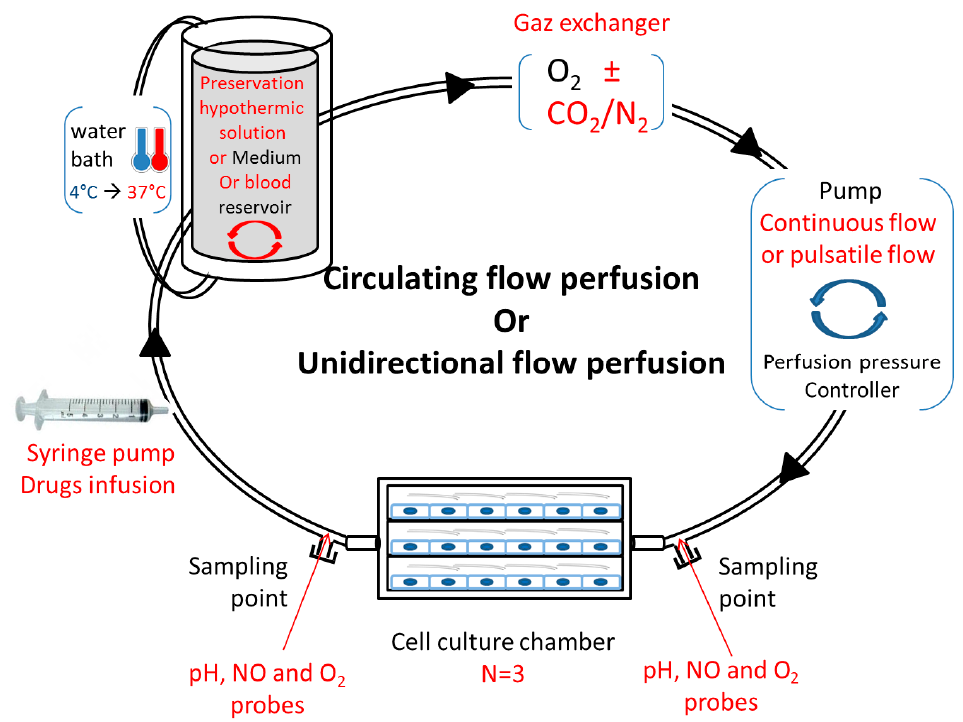
Figure 2. Proposition for an adapted in vitro, physiological ischemia–reperfusion model. Circulating or unidirectional flow perfusion design with adapted materials (red texts) for in vitro ischemia – reperfusion study.